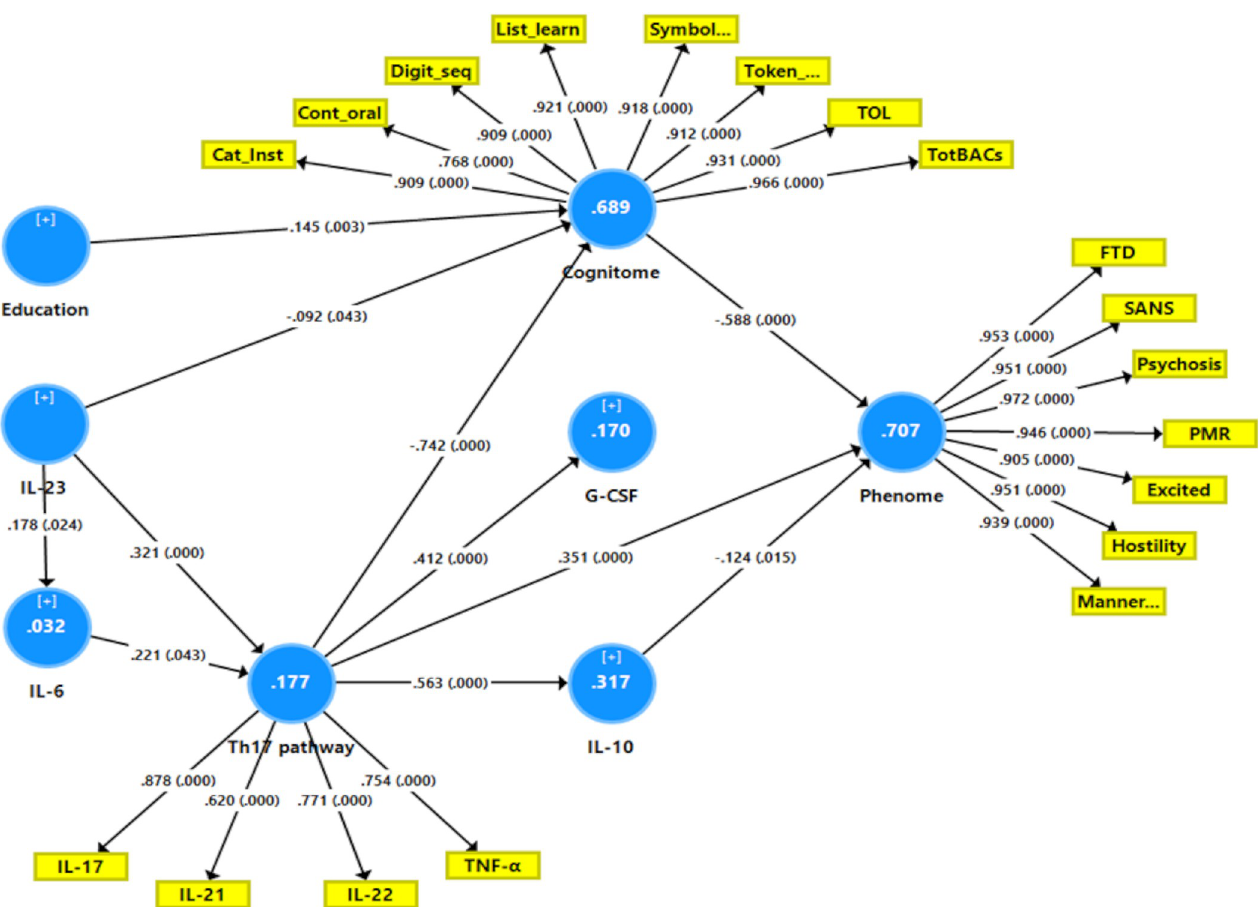
Fig 1. Results of Partial least Squares (PLS) path analysis. Interleukin (IL)-23 and IL-6 are primary input variables. Latent vectors extracted from T helper (Th)17 cytokines, including tumor necrosis factor (TNF)- α , and the generalized cognitive decline (G-CoDe) mediate the effects of IL-6 and IL-23 on the phenome of schizophrenia (outcome indicator). The latter is conceptualized as a latent vector extracted from all symptom domains (reflecting the phenome). The model also considers effects of Th-17 on granulocyte-colony stimulating factor (G-CSF) and IL-10. Cat_Inst: Category Instances; Cont_oral: Controlled Word Association; Digit_seq: Digit Sequencing Task; List_learn: the List Learning test; Symbol..: Symbol Coding; Token..: token motor task; TOL: Tower of London; FTD: formal thought disorders; SANS: negative symptoms; PMR: psychomotor retardation; Excited: excitation; Manner..: mannerism. White figures in circles: explained variance. Shown are the pathway coefficients (p values) and factor loadings (p values).